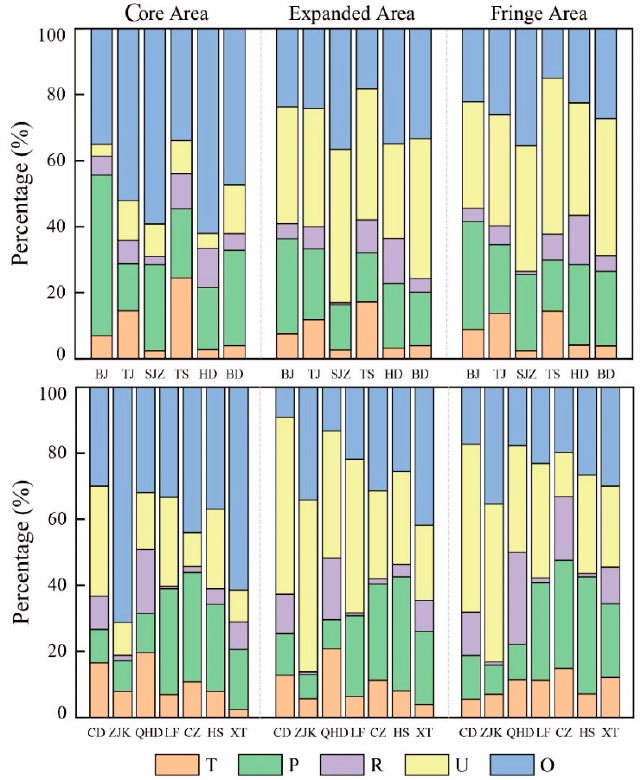
Figure 7. Regional statistics of the contribution of each factor to FVC changes. T, P, R, and U refer to temperature, precipitation, radiation, and urbanization, respectively, and O represents the other factors not considered in this study.